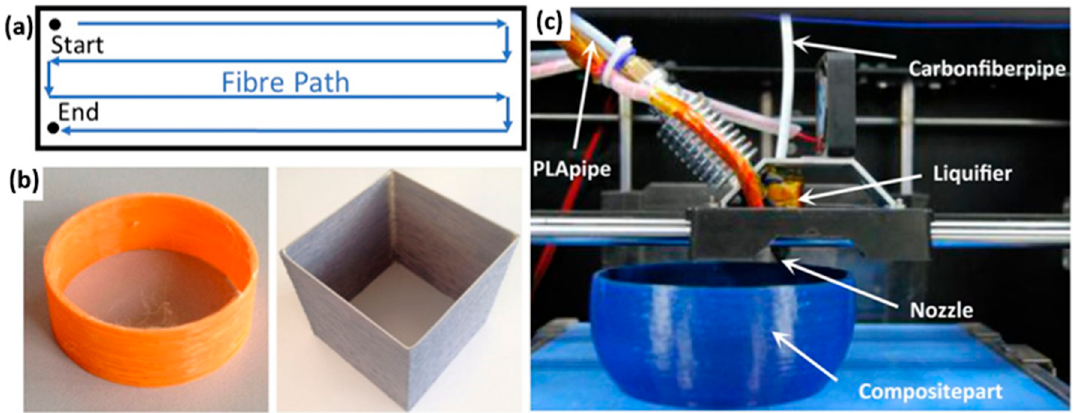
Figure 8. ( a ) Example of a raster pattern generated for printing tensile testing samples [41]. ( b ) Objects printed using “spiral” generated by an FFF slicer software [47]. ( c ) Printer producing a bowl-shaped component from PLA/CF [45].